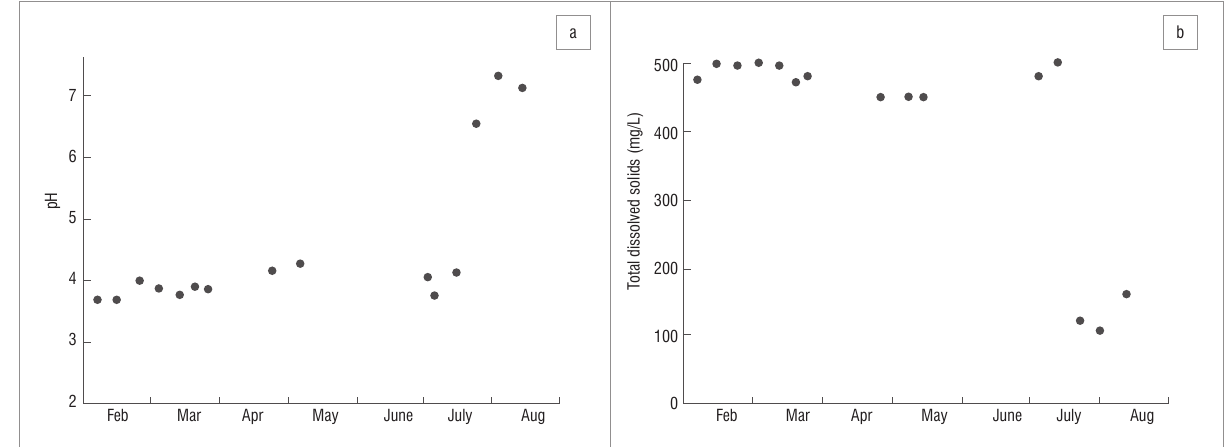
Figure 1: Map showing the locations of Carolina and other places referred to in the text.